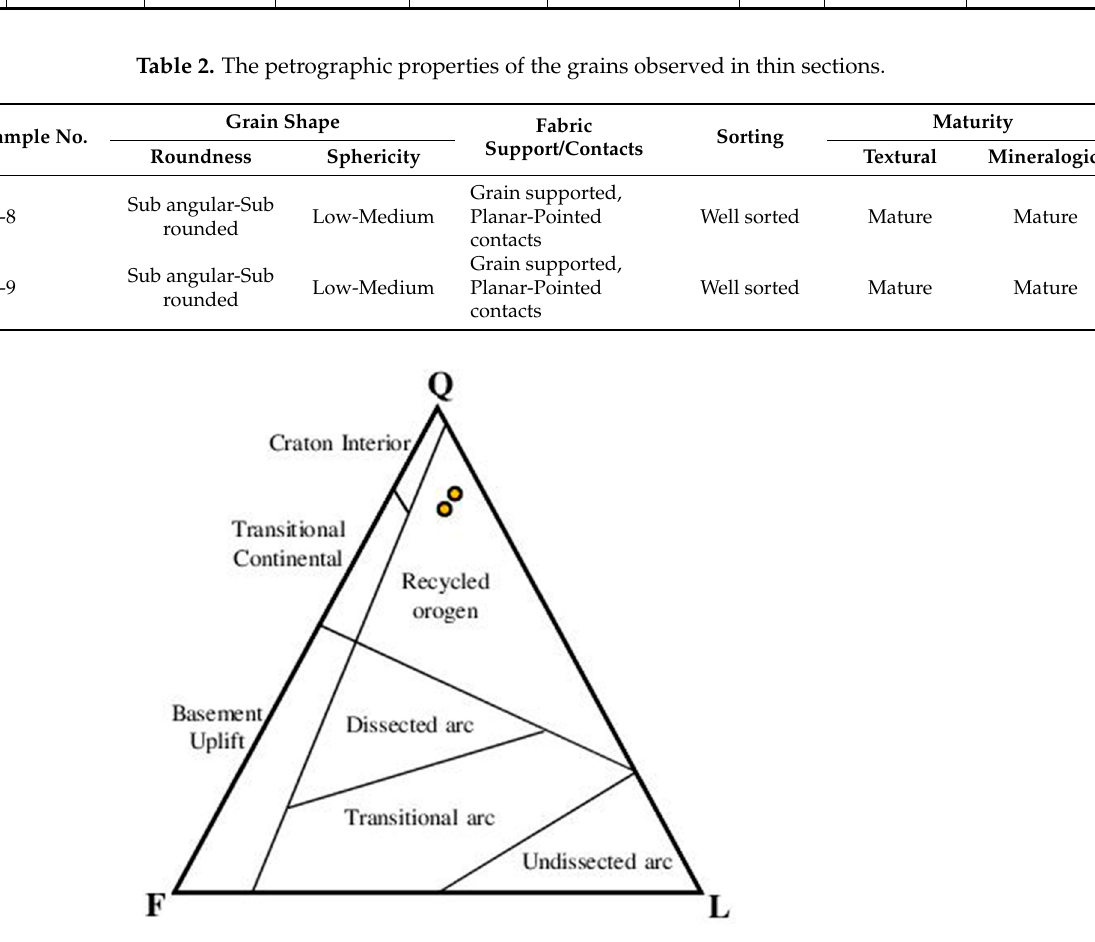
Table 2. The petrographic properties of the grains observed in thin sections.